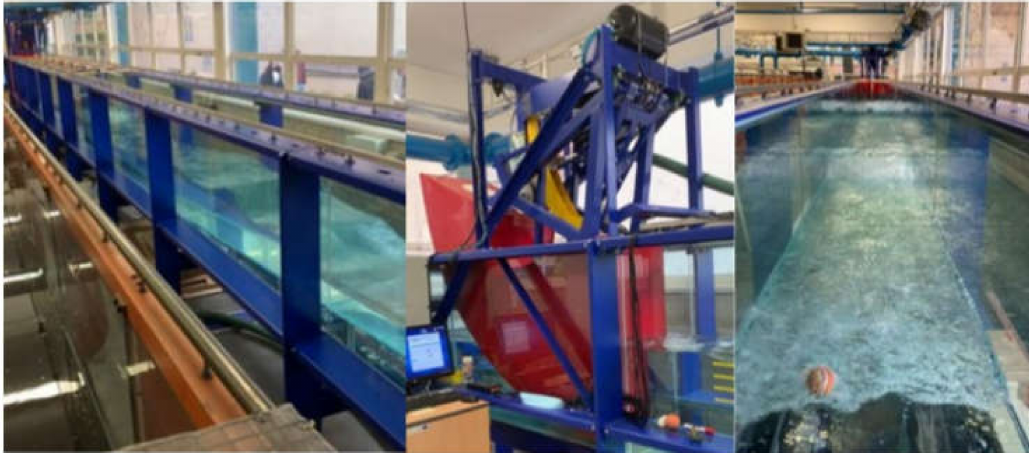
Figure 1. Wave flume apparatus. Example of wave generation along the flume ( left ), wave generator at the upstream section of the flume ( centre ), and dissipation beach at the downstream section of the flume ( right